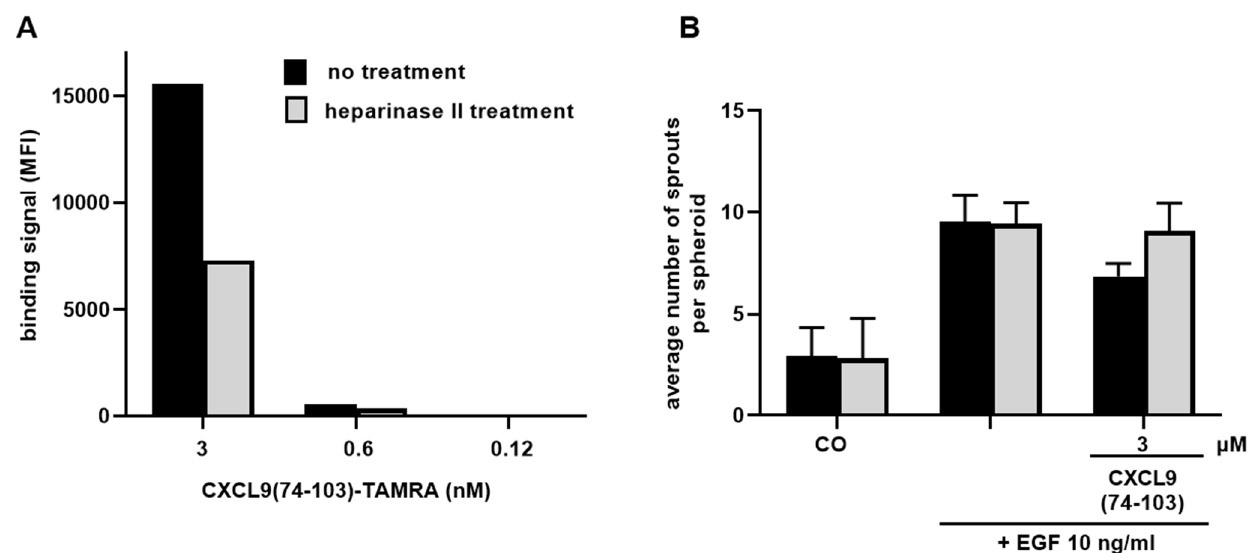
Figure 8. CXCL9(74-103) relies on cell surface HS for binding to endothelial cells and for exerting its anti-angiogenic activity. ( A ) The binding of different nanomolar concentrations of fluorescent TAMRA-labeled CXCL9(74-103) to HMVECs after incubation with or without 0.75 U/mL of heparinase II at 37 °C for 2 hours was evaluated via flow cytometry. The fluorescence was quantified, and the median fluorescence intensity (MFI) is shown. Results of 1 representative experiment out of 3 independent experiments are shown. ( B ) The average number of sprouts per spheroid in response to 10 ng/mL EGF and the inhibition thereof in the presence of 3 µM CXCL9(74-103) was analyzed when spheroids were treated with heparinase II or left untreated. The results shown [mean (±SEM)] are derived from two independent experiments.